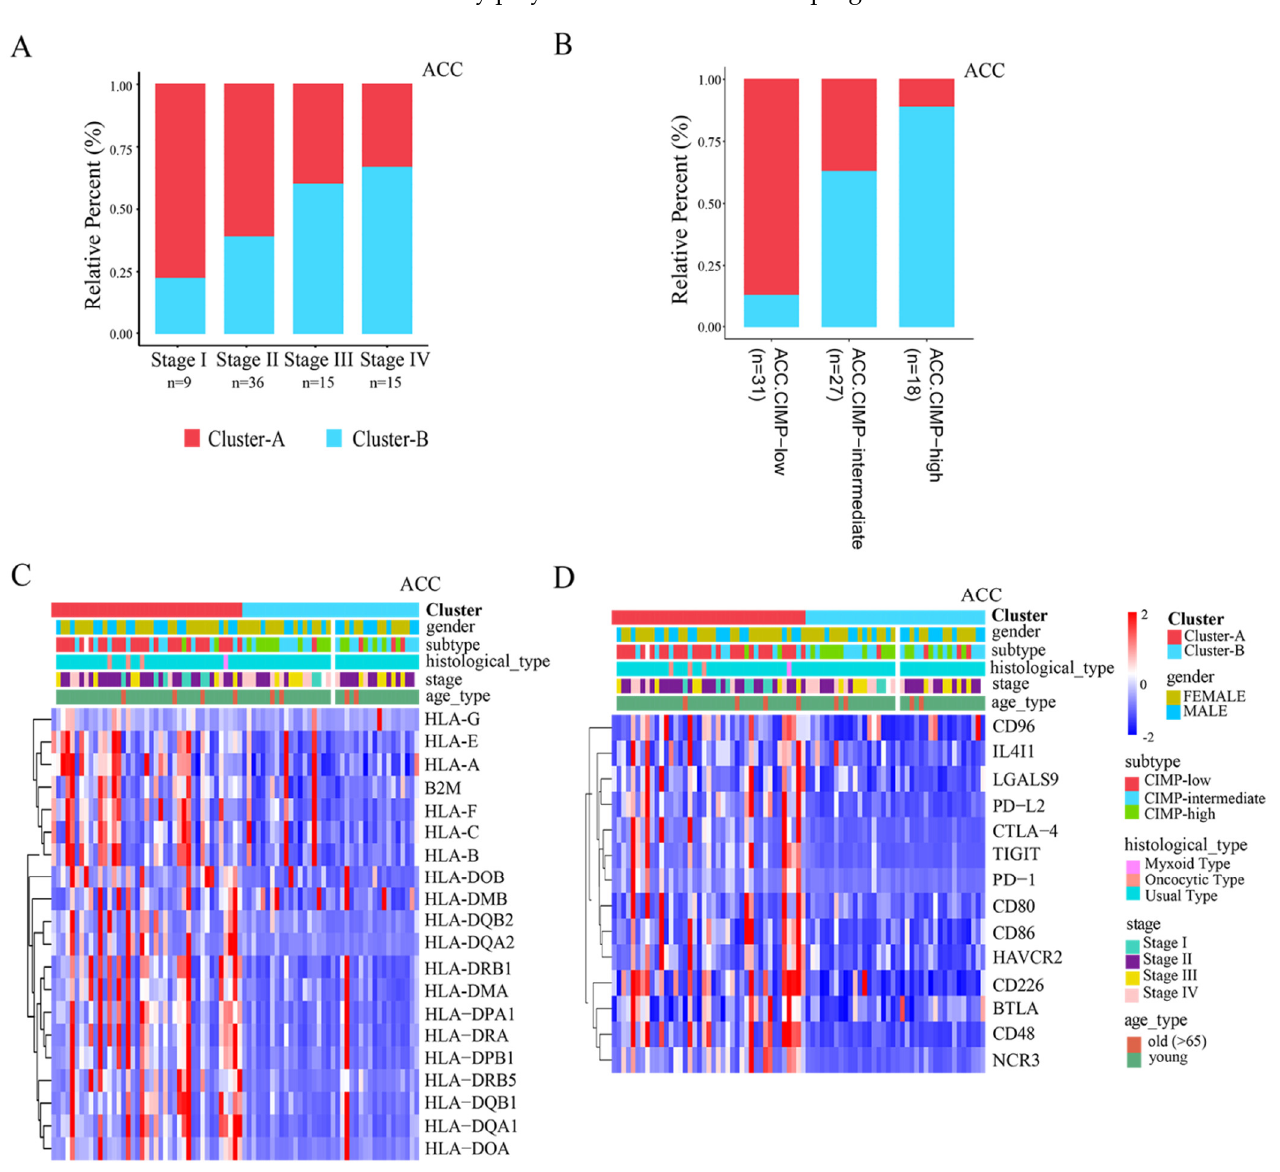
Figure 5. Clinical relevance and immunotherapy sensitivity association of the two APOBEC-mediated patterns in ACC. ( A , B ) The proportion of the two APOBEC-mediated patterns in tumor staging and molecular subtypes in ACC. CIMP-high, CpG island hypermethylation; ( C , D ) Heatmaps comparing expression profiles of HLA and antigen presenting genes and immune checkpoints mole- cules between two the APOBEC-mediated patterns.